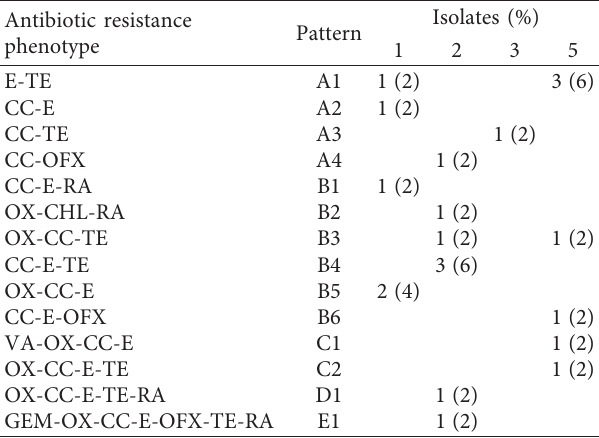
Figure 1: S. aureus CFU/g of pasteurized cheese for each brand analyzed. Boxes (in gray color) and error bars (in black) represent the median and standard deviation according to the Kruskal–Wallis statistical test. Table 2: Antibiotic resistance profiles of S. aureus isolates from pasteurized cheese.